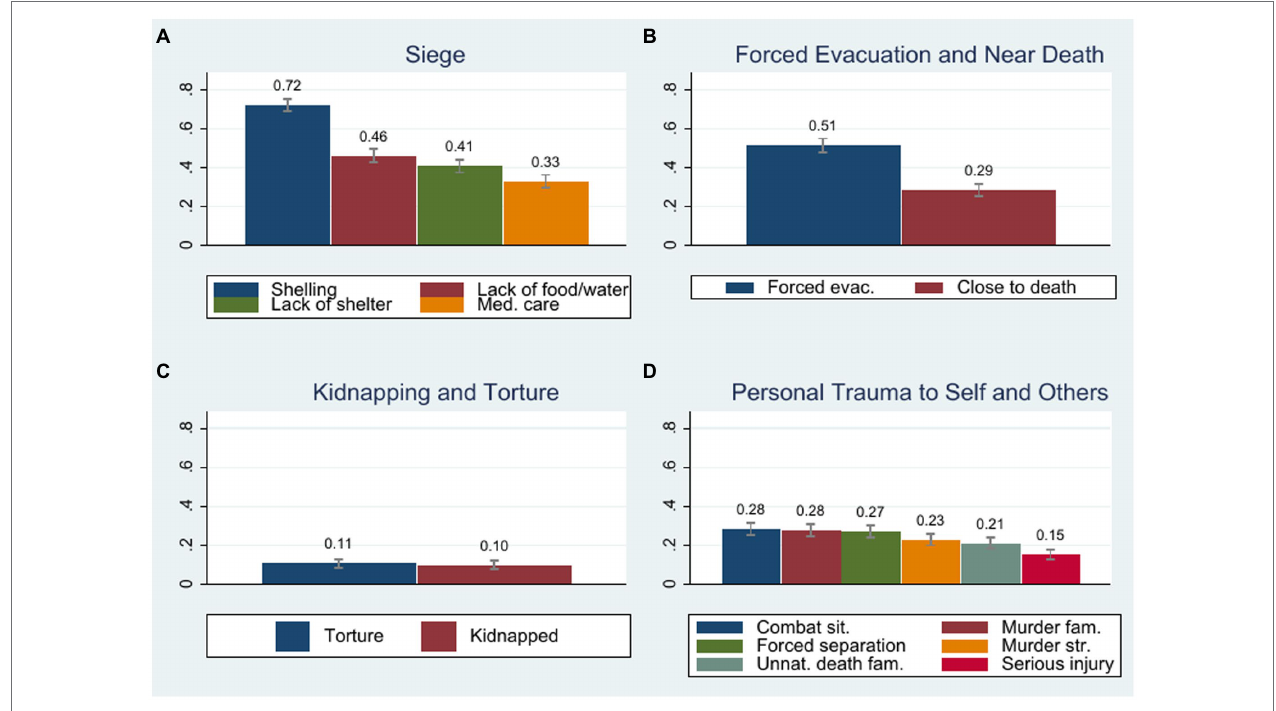
FIGURE 4 | Four subtypes of traumatic events. Capped ranges indicate 95% confidence